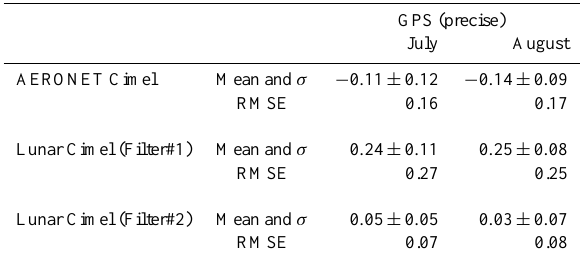
Table 4. Mean, standard deviation σ and RMSE (cm) of the PWV difference (photometer minus GPS data) obtained from the com- parison study between diurnal CA, nocturnal LC and GPS (precise